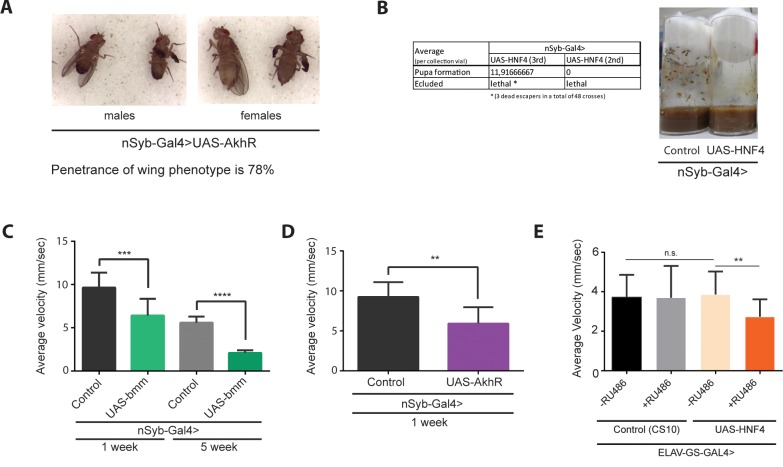
Developmental and adult stage effects induced by neuronal overexpression of AkhR, bmm and dHNF4 (A) Description of lethality effect elicited by overexpressing dHNF4 specifically in neuronal tissue resorting to two independent lines (on the 2nd and 3rd chromosomes). Picture represents the comparison of pupa formation between flies overexpressing dHNF4 (nSyb-GAL4>UAS-dHNF4) and age-matched control flies. (B) Picture denoting wing phenotype developed through overexpression of AkhR in neuronal tissues. Penetrance of wing phenotype was 78%. (C) Negative geotaxis performance of neuronal overexpression of AkhR. (nSyb-GAL4>UAS-AkhR) at 1 week of age compared to age-matched control flies. (**p<0.01; SEM is indicated with n = 140 flies; Paired Student’s t-test) (D) Negative geotaxis performance of neuronal overexpression of bmm (nSyb-GAL4>UAS-bmm) at 1 and 5 weeks of age compared to age-matched control flies. (***p<0.001;****p<0.0001; SEM is indicated with n = 180 flies; Paired Student’s t-test). (E) Negative geotaxis performance of neuronal overexpression of dHNF4. Induction of GAL4 (OE) started at 1 week of age (ELAV-GS-GAL4>UAS-dHNF4) and flies were tested at 3 weeks of age (2 week treatment period with 200μM of RU486). (**p<0.01; SEM is indicated with n = 120 flies; Paired Student’s t-test).